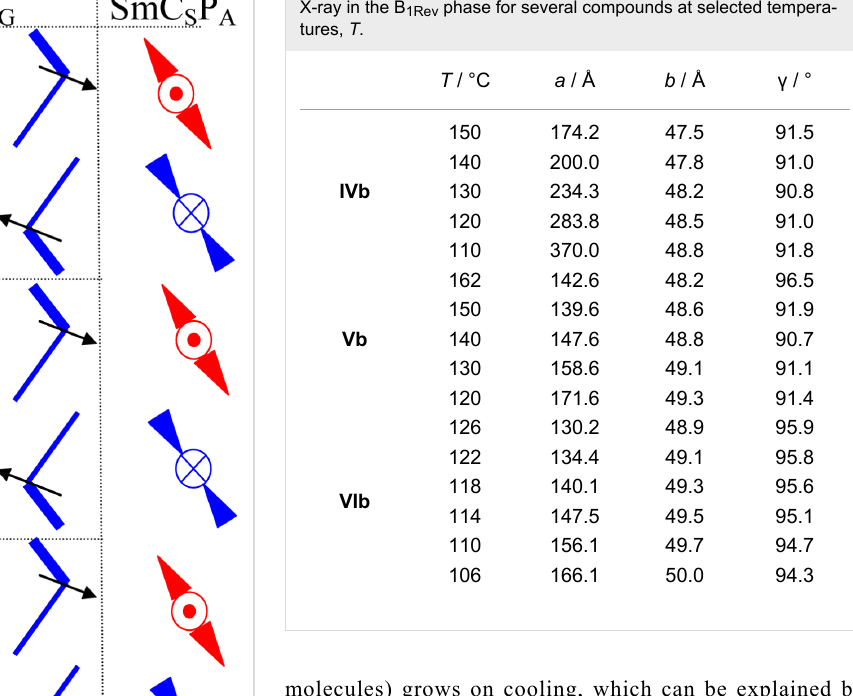
goes beyond the range. Two compounds of series V show two